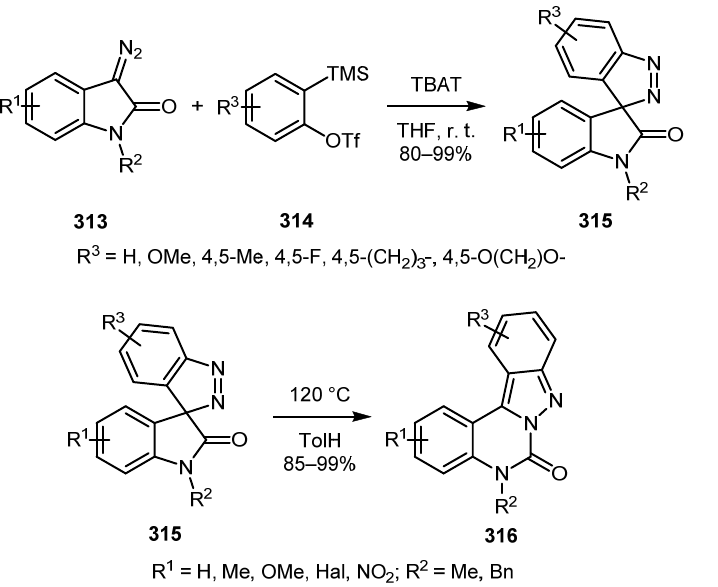
Scheme 76. Synthesis of spiro-3 H -indazoles 315 and their thermal rearrangement into fused 2 H -indazoles 316